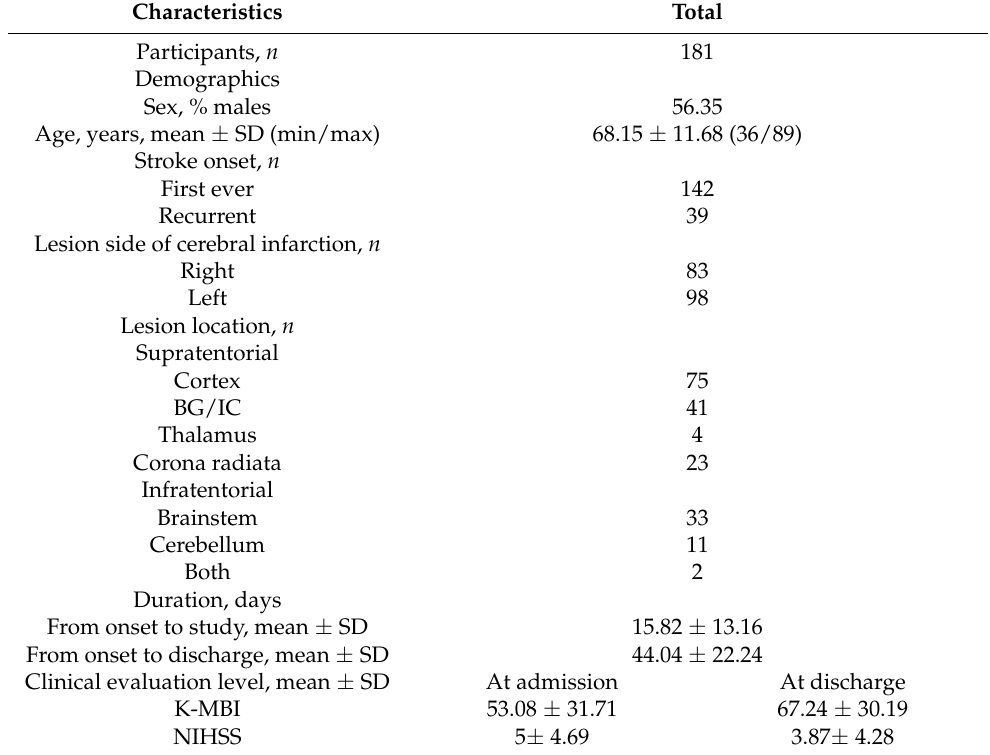
Table 1. Characteristics of stroke